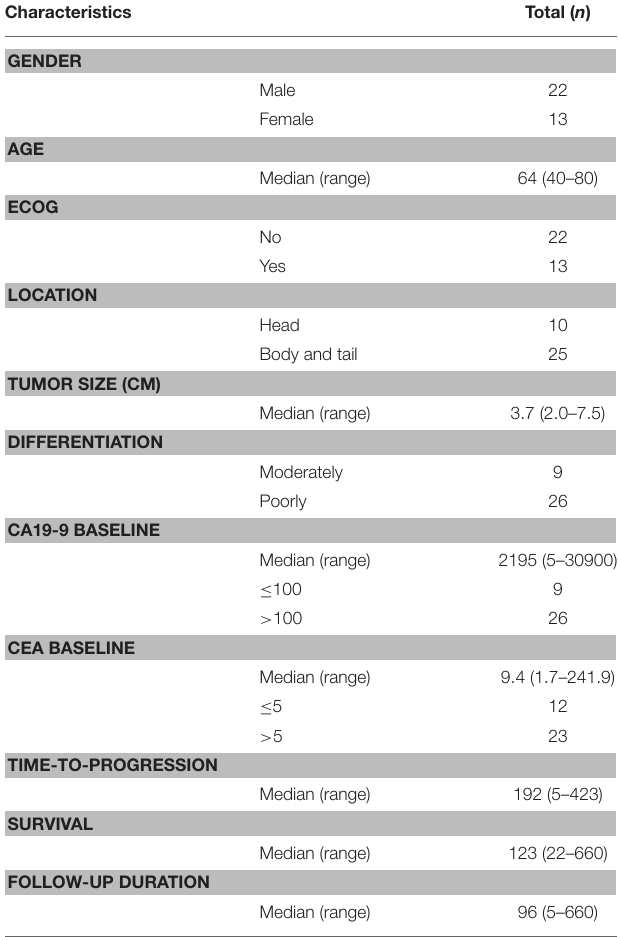
TABLE 1 | Patient characteristics ( n =